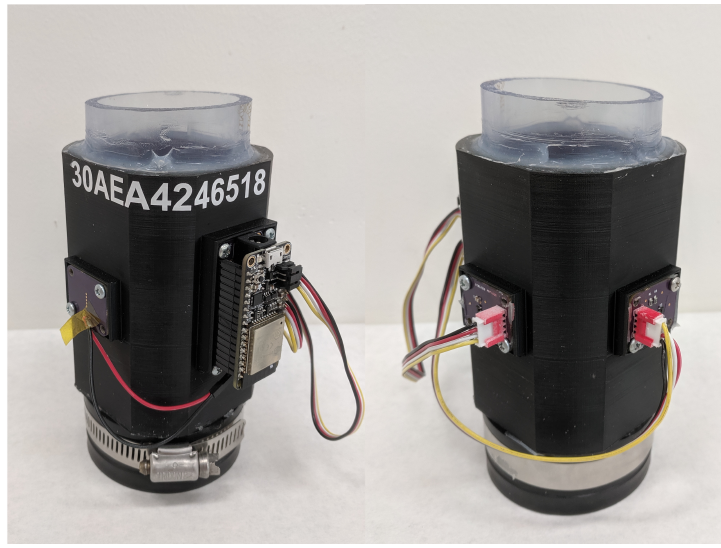
Figure 9. Sensor 18 configured for laboratory